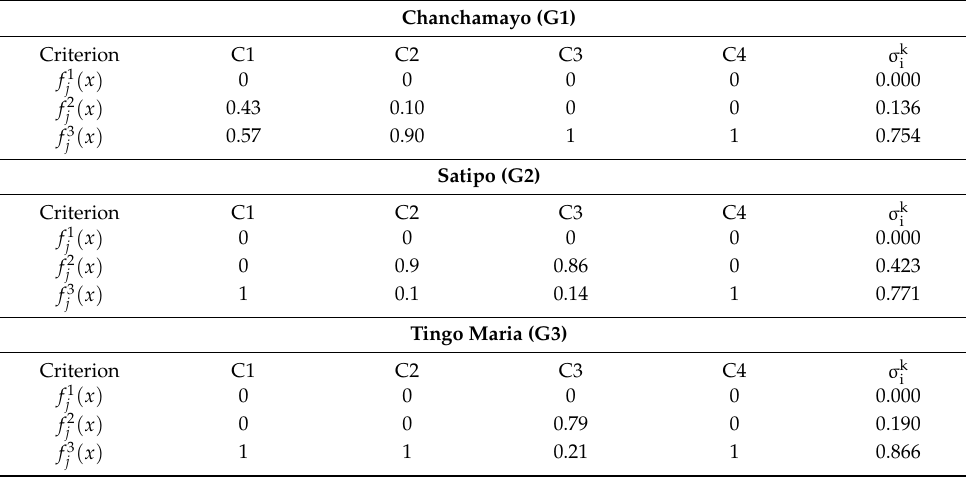
Table 11. Values of the clustering coefficients in the respective